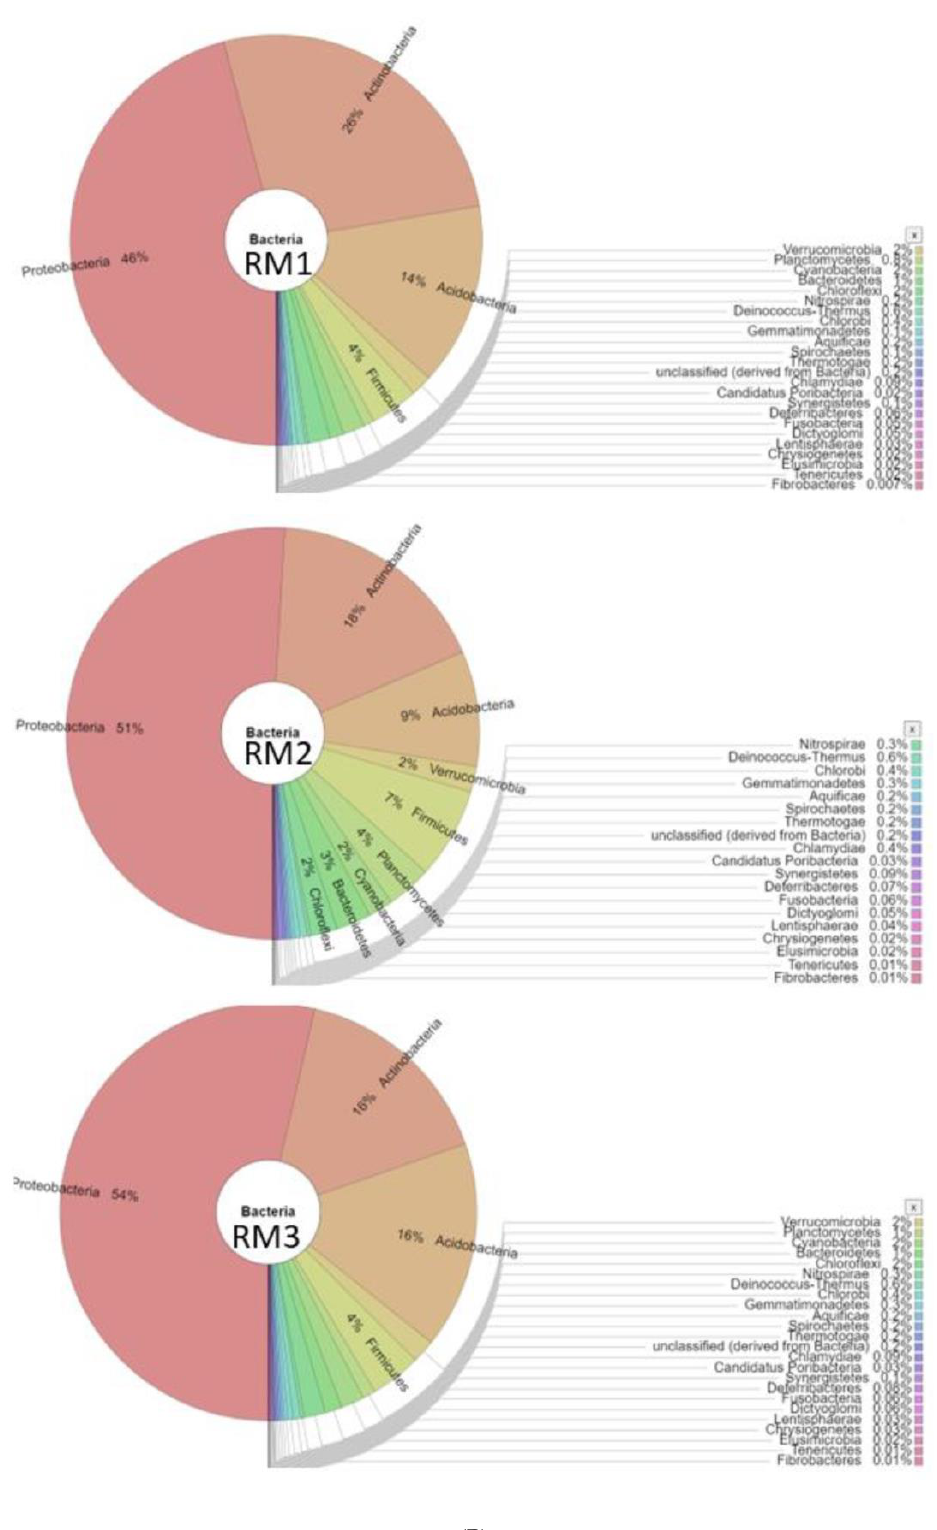
Figure 2. ( A ) Metagenome profiling of total soil bacteriota isolated from RBFR (SK, SP, and SR) based on Krona RSF display. The frequencies of each phylum are presented and reveal the protebacteria as the dominating phylum in all studied sites. ( B ) Metagenome profiling of total soil bacteriota isolated from RMFR (RM1, RM2, and RM3) based on Krona RSF display. The frequencies of each phylum are presented and reveal the protebacteria as the dominating phylum in all studied